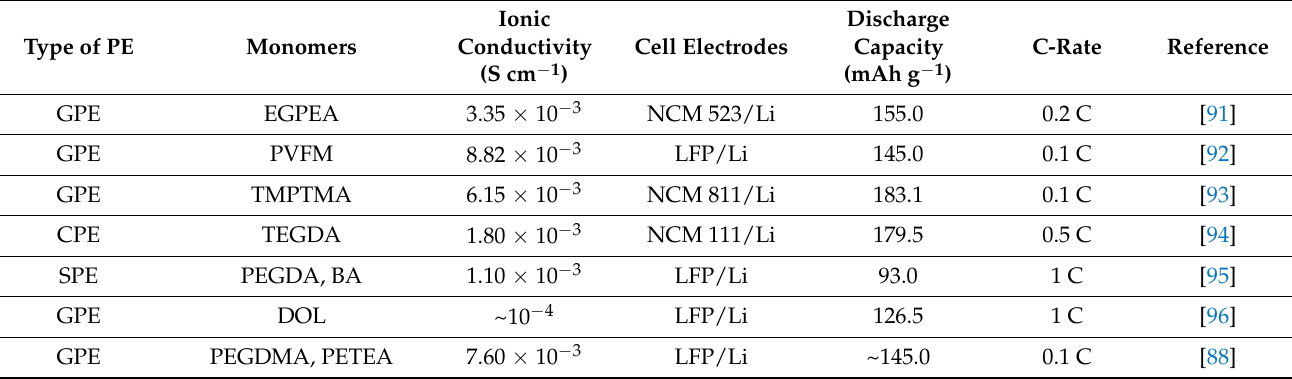
Table 5. Polymer electrolytes using thermal